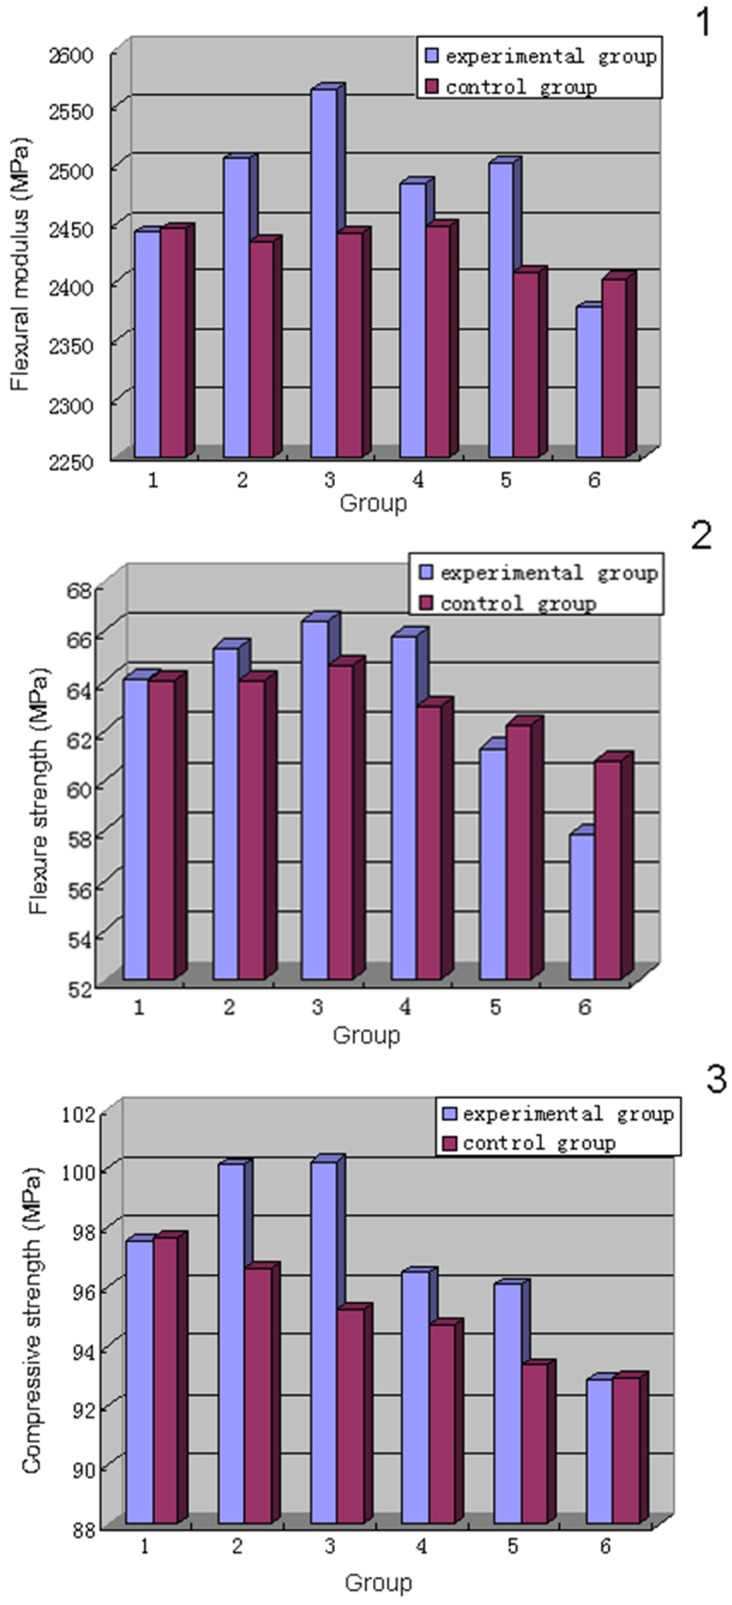
a) Bending moduli, b) bending strengths, and c) compressive strengths of various groups.